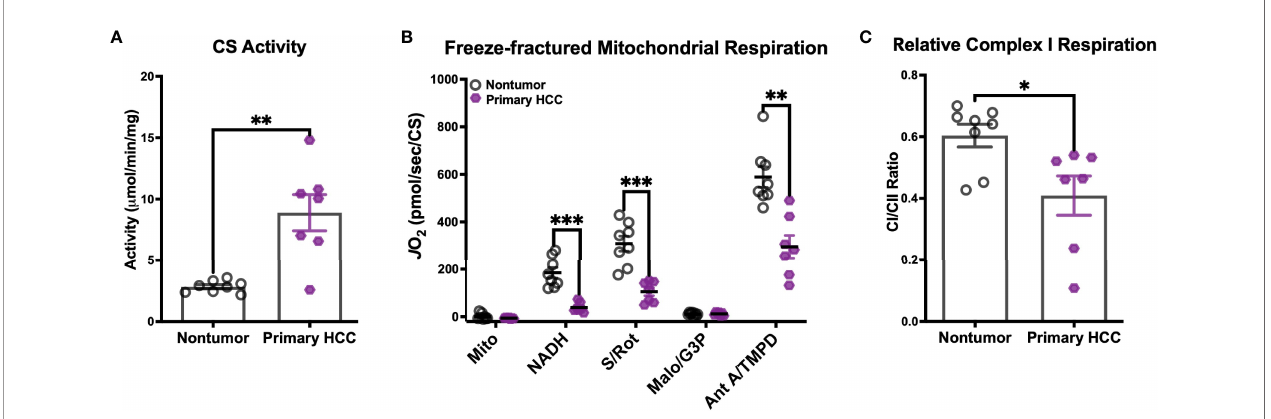
FIGURE 6 | Human primary hepatocellular carcinoma (HCC) tumors display reduced mitochondrial capacity. (A – C) Mitochondria were isolated from fl ash-frozen nontumor liver tissue (Nontumor; n=8) and liver tumor (Primary HCC; n=7) samples from human hepatocellular carcinoma patients for biochemical assessment.